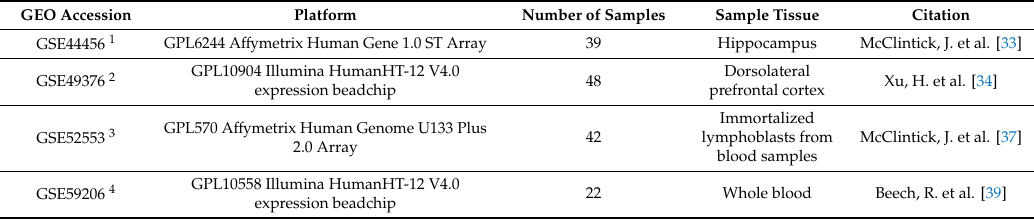
Table 1. Studies selected for analysis after the systematic review. GEO (Gene Expression Omnibus) accession number, platform used, number of samples, sample tissue and citation number are